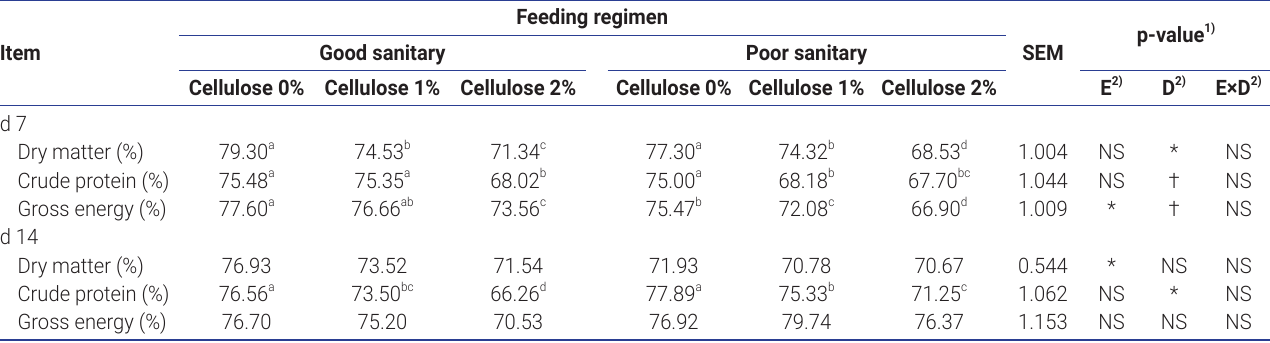
Table 6. Effects of environmental conditions and cellulose levels on apparent ileal digestibility for weaned pig for 14 days after weaning